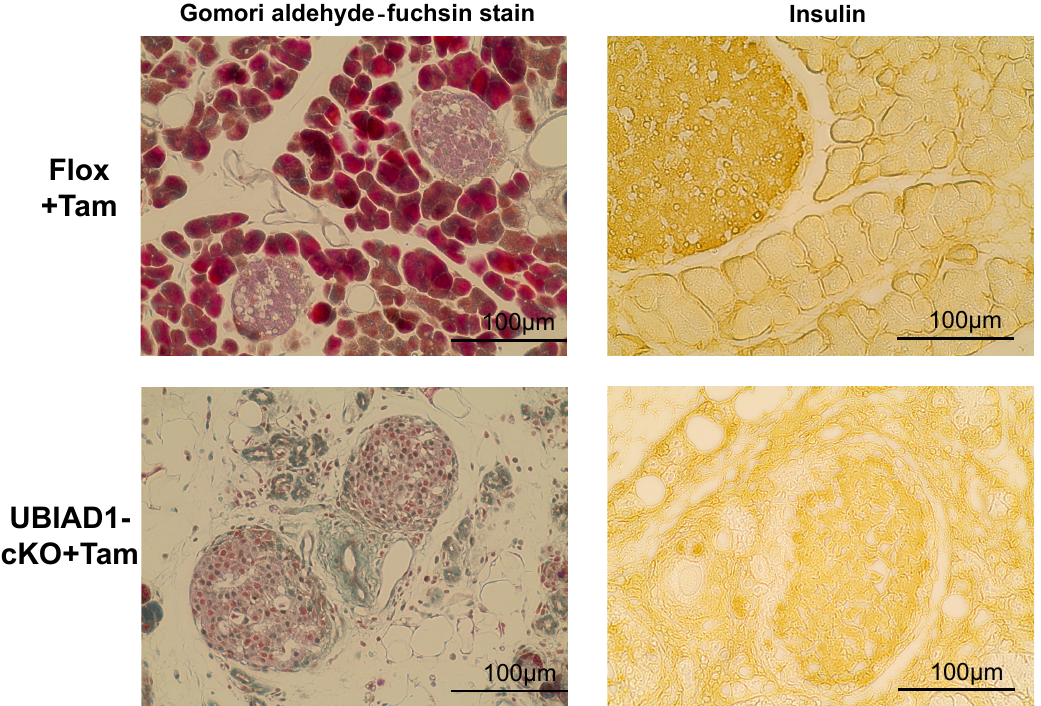
Figure 4. Gomori aldehyde fuchsin and insulin immune-stained pancreas sections from female Flox and UBIAD1-cKO mice at 40 days after administration of tamoxifen. In the Gomori aldehyde fuchsin-stained sections, elastic fibers and pancreatic islet β class cells were stained purple, pancreatic islet δ cells were stained light green, pancreatic islet α cells were stained red, and connective tissue was stained green. Immunohistological staining with insulin specific antibody in the pancreas of the tamoxifen-treated Flox and UBIAD1-cKO mice at 40 days after administration of